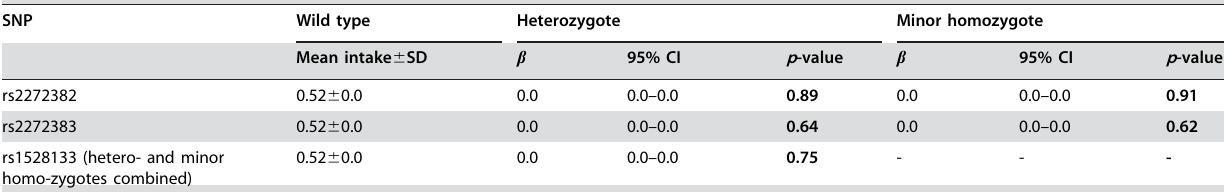
rs1528133 (hetero- and minor homo-zygotes